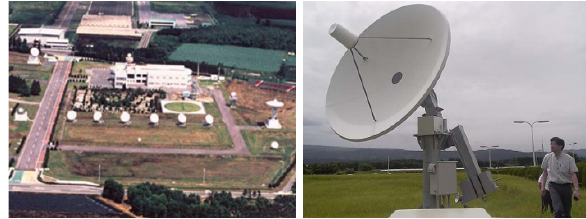
Figure 1. Tokai University Space Information Center (TSIC) seen from an aerial view (a). The 2.4m x-band antenna (b).